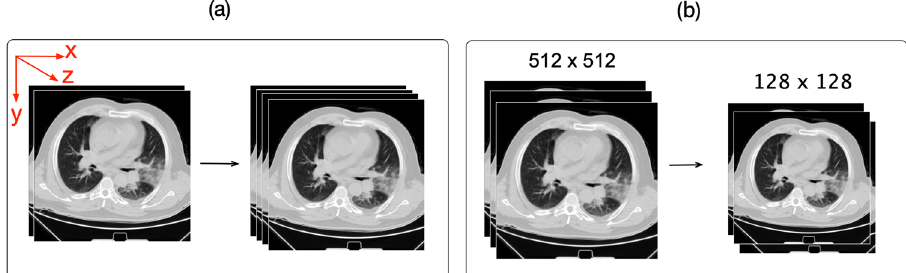
Fig. 7 Schematic representation of the pre-processing phases. a Each patient ’ s CT image (3D) was resampled to isomorphic resolution, while x and y are the image coordinates and z represents the number of slices. b All CT slices (2D) with different sizes were resized to have 128 × 128 pixels on the x and y axis, but the z axis that depicts the number of slices remained intact. Here, a 512 × 512 pixels CT slice is resized into a 128 × 128 pixels CT slice.